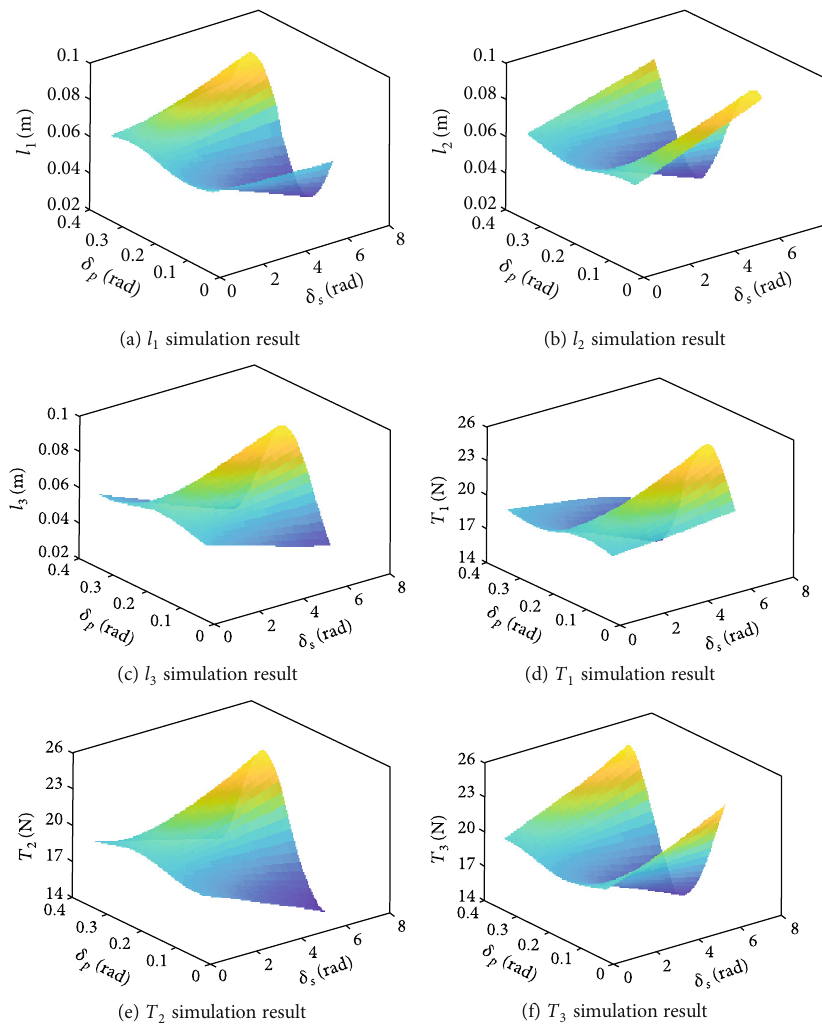
Figure 11: Inverse position and